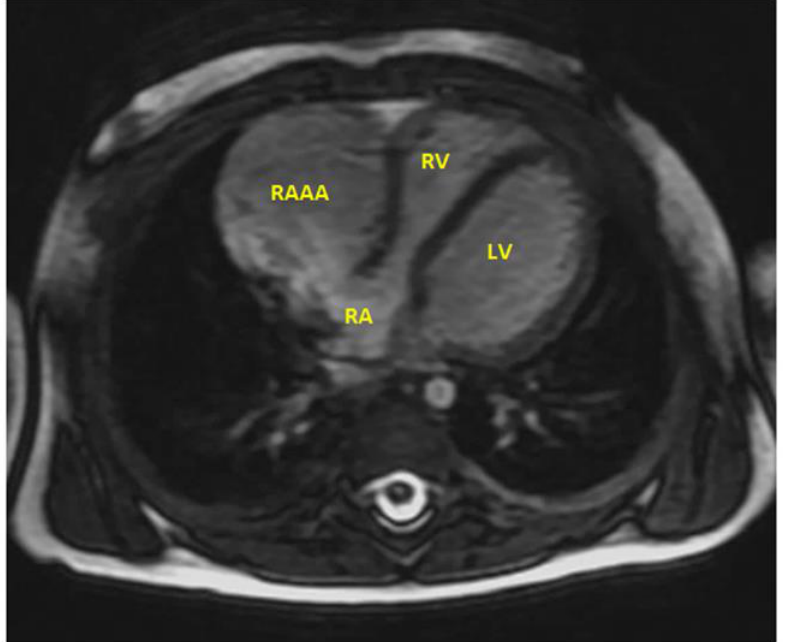
Figure 8. MRI in a ten-month-old infant. A gigantic aneurismal dilatation of the RAAA was de- tected.